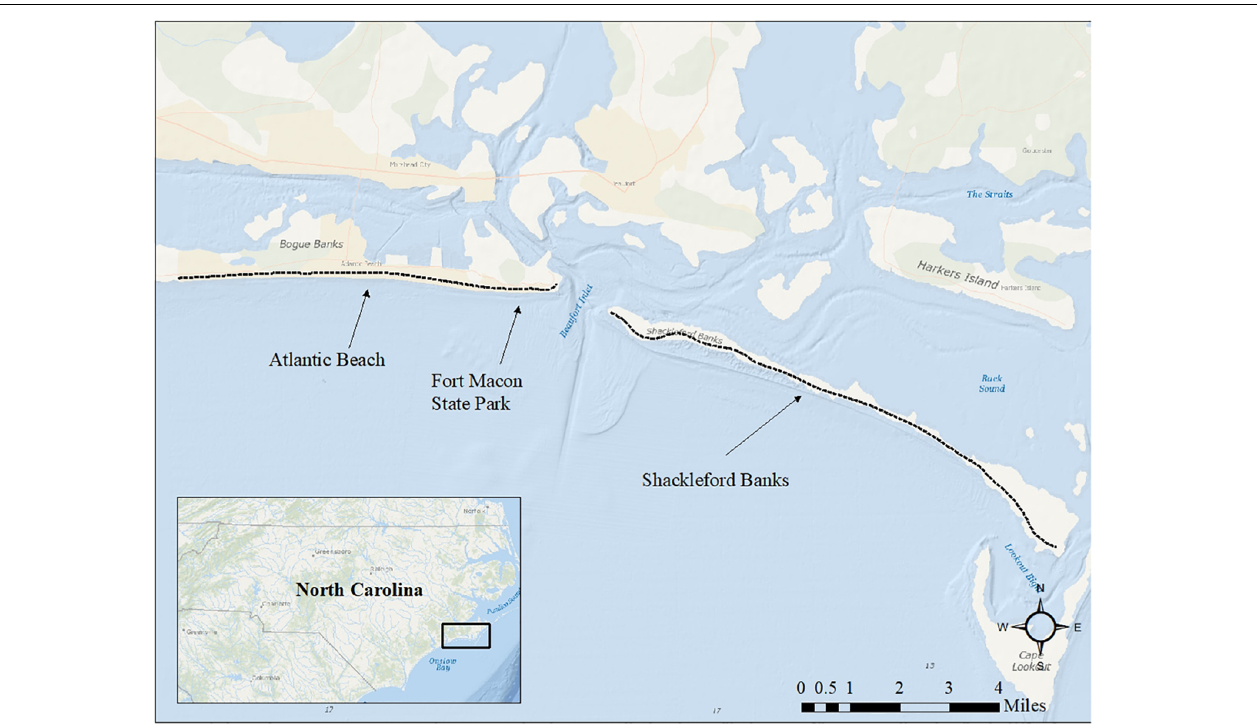
FIGURE 1 | Map of study area: Atlantic Beach, Fort Macon State Park, and Shackleford Banks, NC, United States. Dashed lines represent autonomous terrestrial rover deployments during summer 2017.